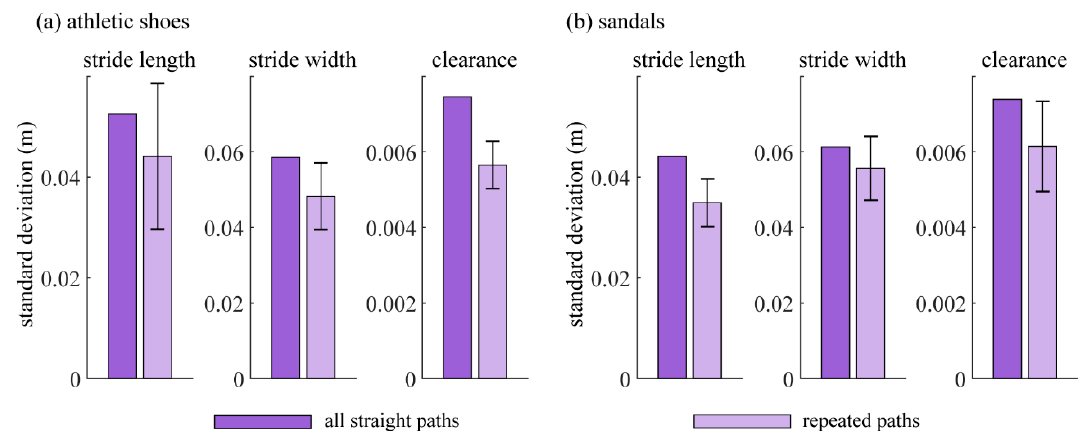
Figure 9 . Comparison of variability of the spatiotemporal gait parameters between all straight paths and repeated paths when wearing ( a ) athletic shoes and ( b ) sandals. Dark columns indicate the variability of each outcome metric using all straight paths over 15 m (standard deviation across strides within 2% of the mean speed). Light columns with error bars indicate the variability of each outcome using only frequently-repeated paths (mean and standard deviation across frequent paths of the standard deviations of the individual paths using strides within 2% of the mean speed).